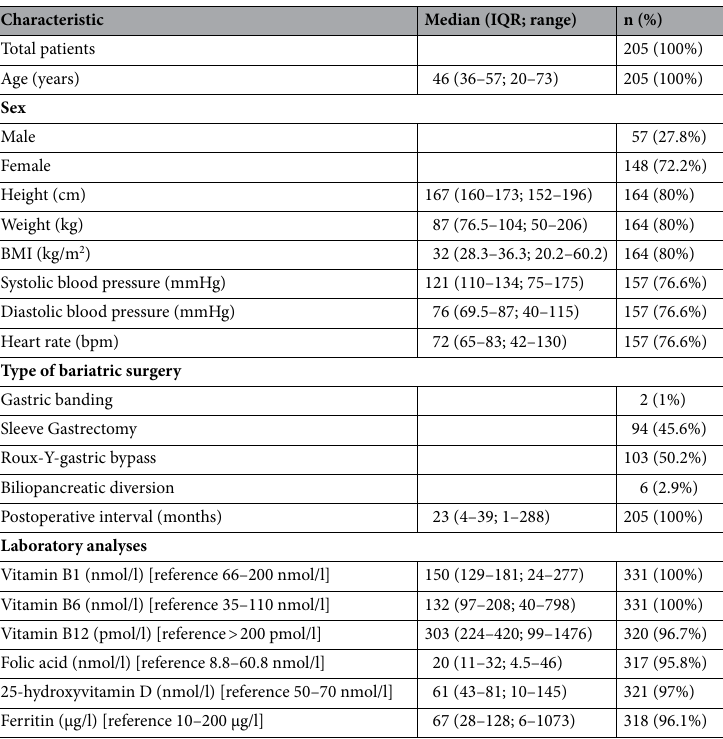
Table 1. Baseline characteristics. Baseline characteristics of all patients after bariatric surgery with regular vitamin B6 measurements in 2017. bpm beats per